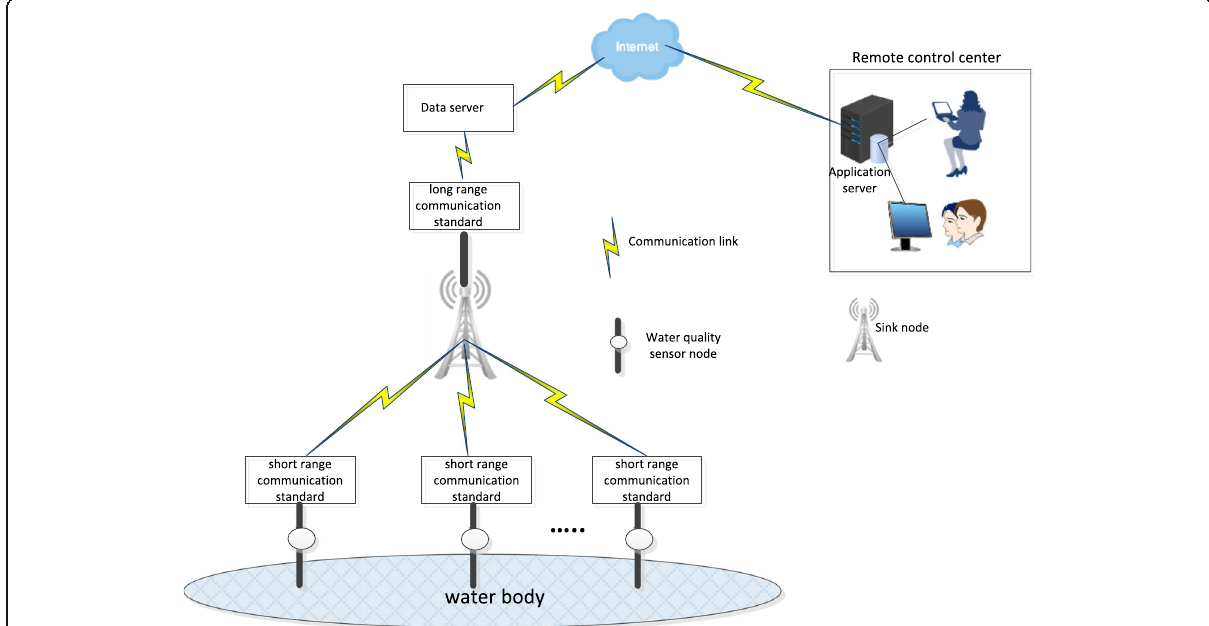
Fig. 1 A typical water quality monitoring system